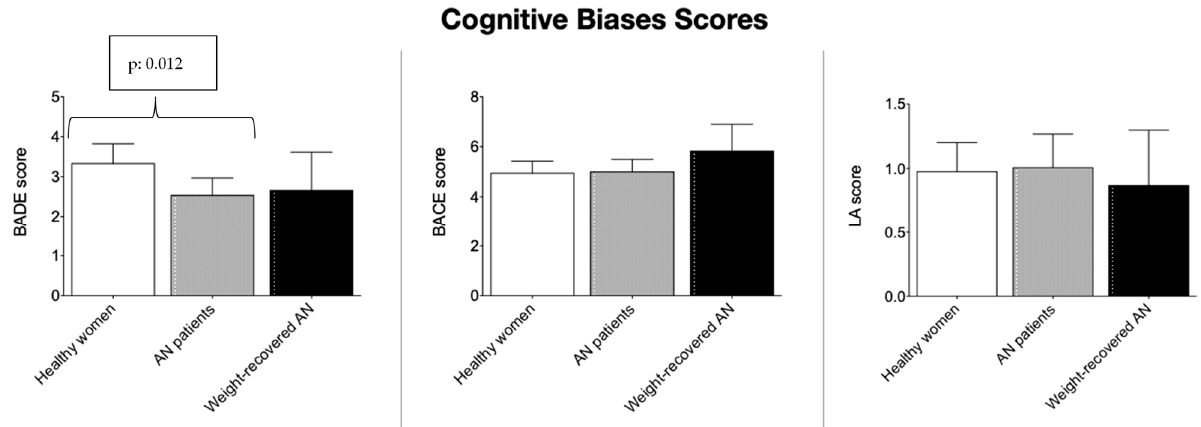
Figure 1. Raw average scores (and their 95% confidence intervals) in the three groups investigated for Bias Against Disconfirmatory Evidence (BADE), Bias Against Confirmatory Evidence (BACE), and liberal acceptance (LA). The error bars indicate the standard error measurement (SEM).